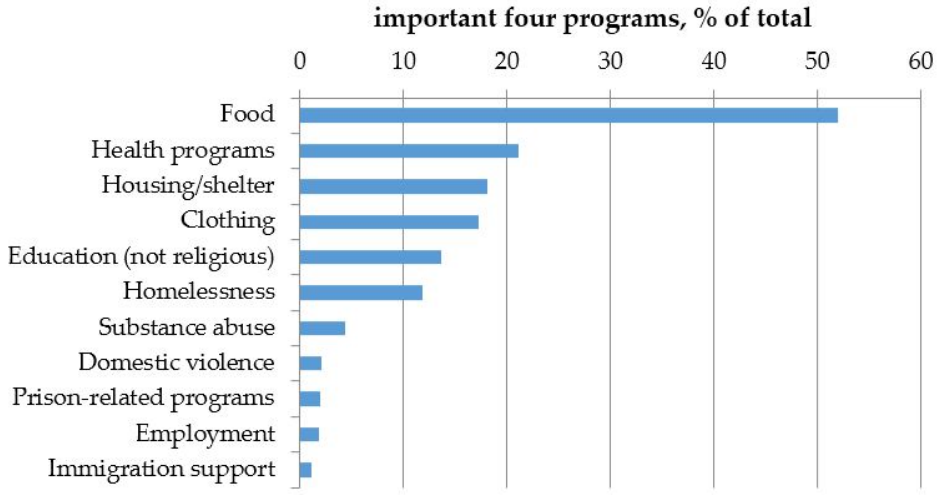
Figure 1. Congregational participation in selected social service program areas, 2012.